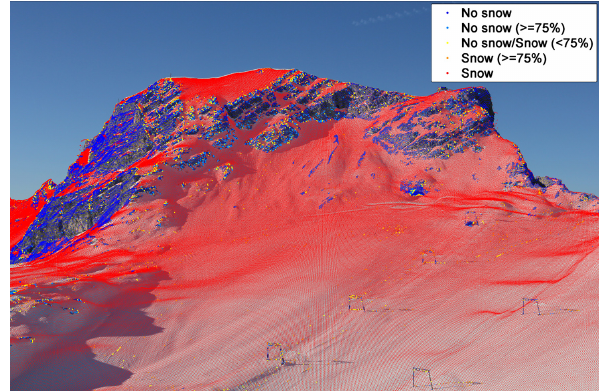
Figure 6. Results of the PCA-based classification of the SLR pho- tograph on 17 November 2011: snow is classified in red, snow-free areas are depicted in blue. The pixels classified as probably snow (orange), probably no snow (light blue) and highly unsure (yellow) are enlarged for the sake of clarity. Only about 3.6% of all classified pixels fall within one of the three probability categories and hence are assumed as unsure